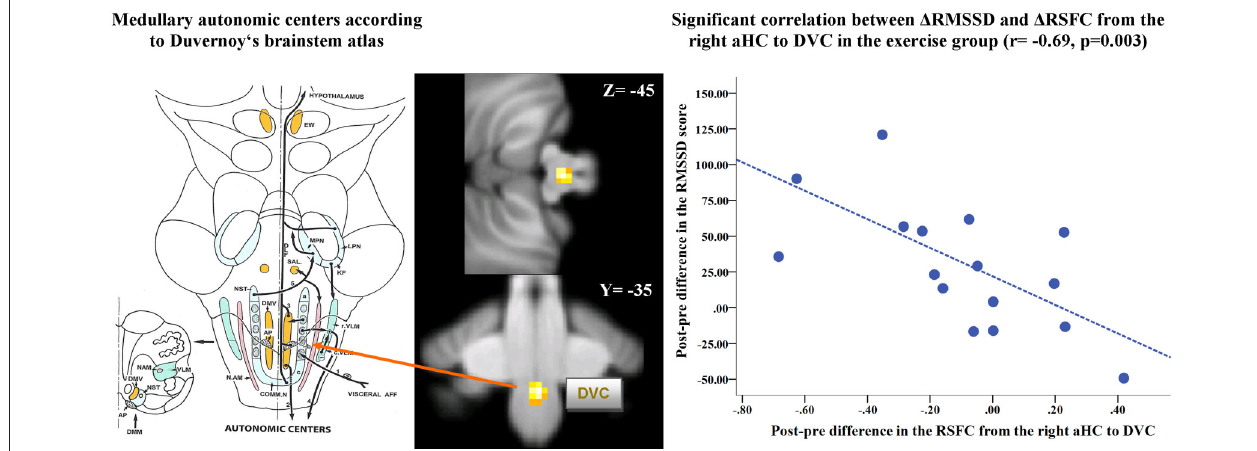
FIGURE 6 | Scatterplot of the significant negative correlation between exercise-induced changes in the functional connectivity from the right aHC to DVC and RMSSD. On the right-hand side, the scatterplot illustrates the significant negative correlation in the exercise group between post-pre differences of functional connectivity of the right aHC to DVC and post-pre differences in RMSSD, which was measured during the resting state fMRI. RMSSD is considered as a parameter of heart rate variability, reflecting the integrity of vagus nerve-mediated autonomic control of the heart. On the left-hand side, a figure of the anatomical position of the autonomic medullary centers from the Duvernoy’s Atlas of the Human Brain Stem and Cerebellum is depicted, corresponding to the significant cluster (DVC) of decreased function connectivity from the aHC after exercise. NST, nucleus of the solitary tract (a: rostral portion, b: midportion, c: caudal portion); COMM.N, commissural nucleus; DMV, dorsal motor nucleus of the vagus; AP, area postrema; DLF, dorsal longitudinal fasciculus; VLM, ventrolateral medullary center (r: rostral portion, c: caudal portion); N.AM, nucleus ambiguous; SAL, salivatory nucleus; MPN, medial parabrachial nucleus; LPN, lateral parabrachial nucleus; KF, nucleus of Kölliker-Fuse; EW, Edinger-Westphal. “With kind permission from Springer Science+Business Media: Duvernoy’s Atlas of the Human Brain Stem and Cerebellum, Section III: Major Functions of the Human Brain Stem, 2009, page 115, Naidich, T.P., Duvernoy, H.M, Delman, B.N., Sorensen, A.G., Kollias, S.S., Haacke, E.M., Figure